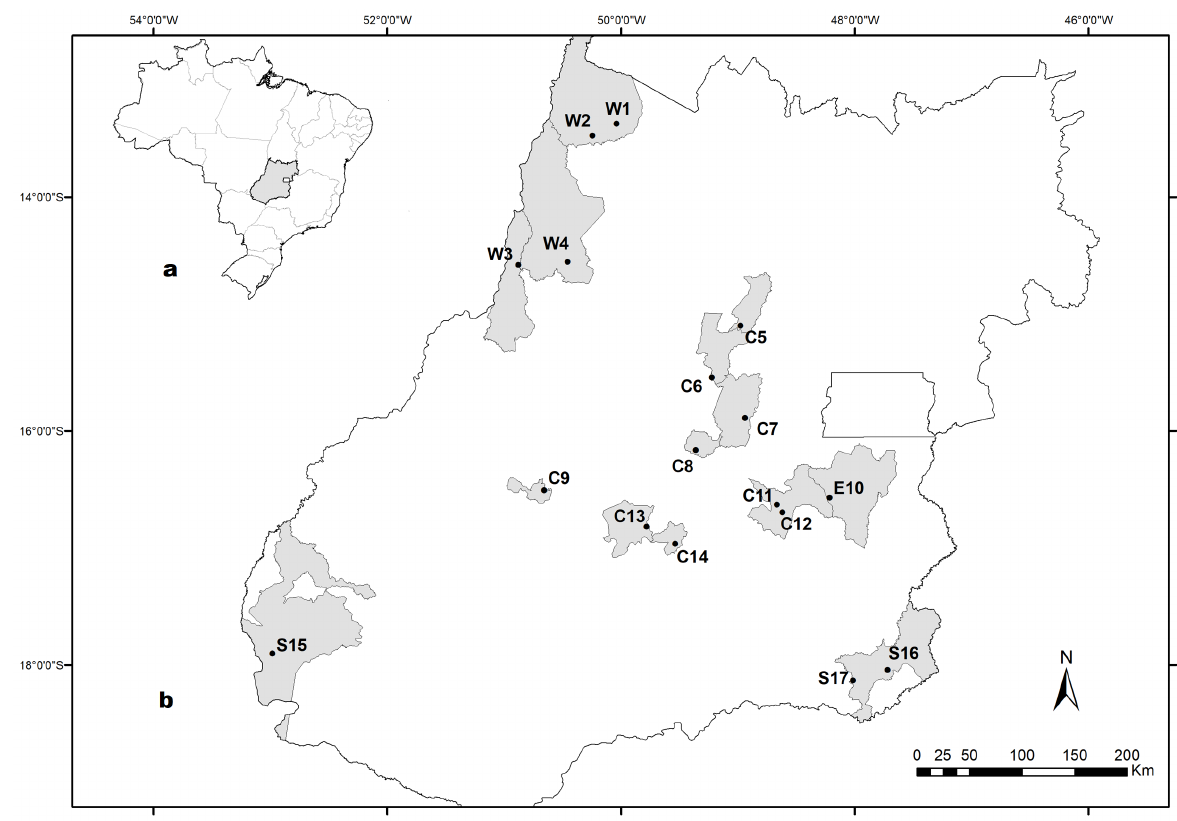
Figure 1 – ( a ) Map of Brazil with Goiás State highlighted. ( b ) Location of the seventeen forest fragments sampled in the State of Goiás. The gray areas are the municipalities where the fragments are located. The forest fragments are signaled with black dots. The fragments are numbered from the west to the south region and identified with the initial letters of the respective regions of the State (W: west; E: east; C: central; S: